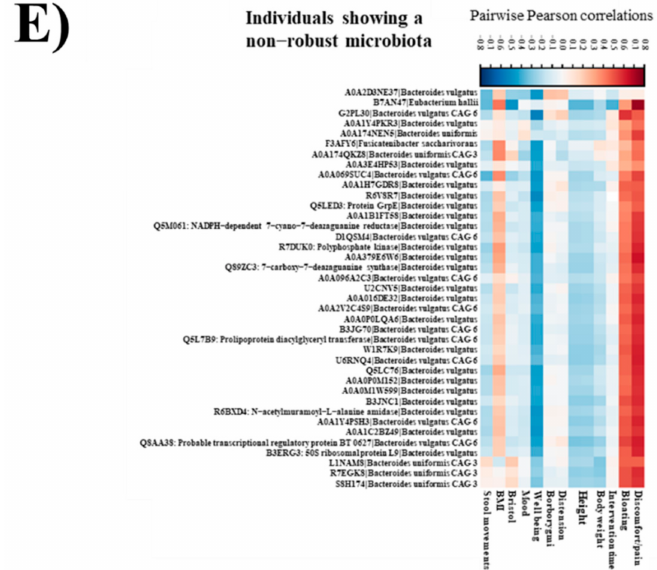
Figure 4. ( A ) Clustering of metagenomic samples of metabolic pathway abundances using. Bray–Curtis dissimilarity method was used to determine which participants were grouped. Several samples from the same participant corresponding to Western-Type Diet (WD) and Fibre-Enriched Mediterranean-Type Diet (FMD) interventions were discriminated from the rest of the individuals, highlighting a robust microbiota was not significantly affected by dietary interventions. ( B ) Differen- tial profiles for robust and non-robust microbiotas through multi-omic data integration of metabolic profiles and metabolic pathways determined by shotgun sequencing using the DIABLO biomarker discovery pipeline. ( C ) Variable importance coefficients obtained in DIABLO pipeline for metabolites and metabolic pathways in robust and non-robust